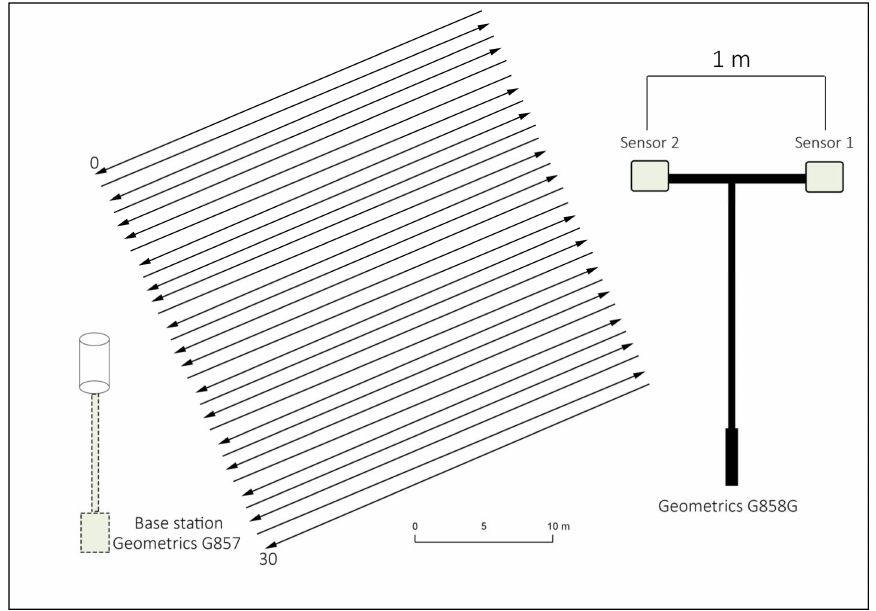
Figure 7. The pattern of walking direction during data acquisition with Geometrics G858G (right). Left: the position of the proton magnetometer Geometrics G857.